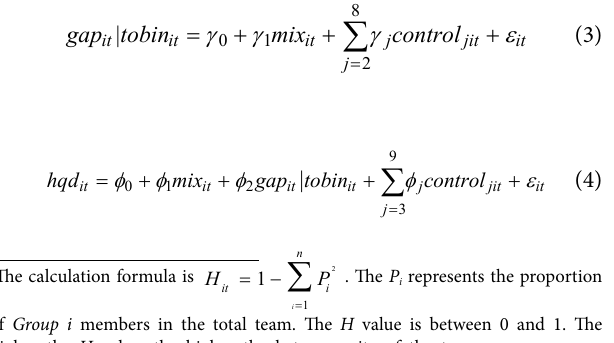
of state-owned enterprises in the new